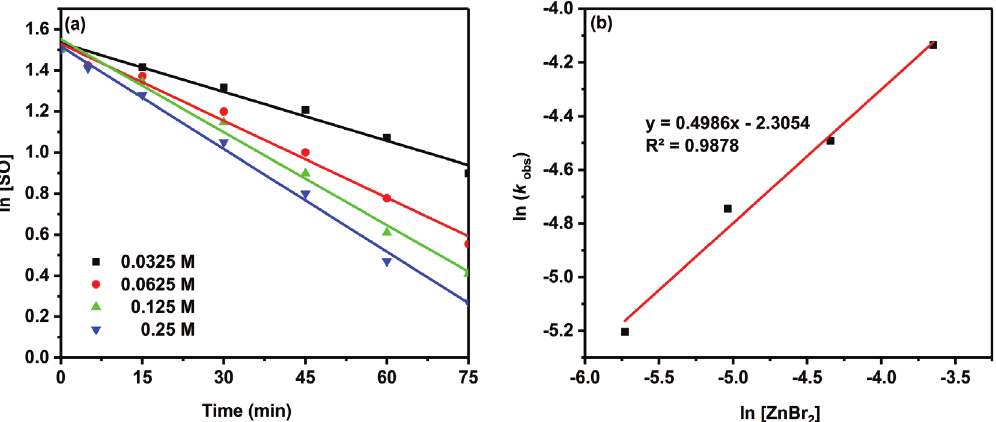
(0.0325-0.25) M (b) Double natural logarithmic 2